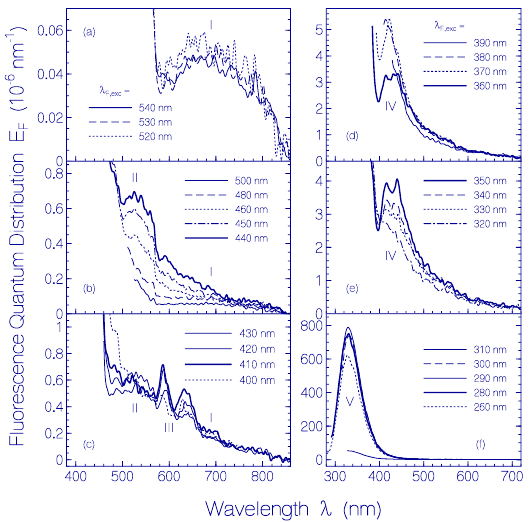
Figure 2. Fluorescence emission quantum distributions E F ( λ ) of fresh centrifuged CaRh in pH 7.3 HEPES/MOPS buffer for various fluorescence excitation wavelengths in the regions from ( a ) 540 to 520 nm; ( b ) 500 to 440 nm; ( c ) 430 to 400 nm; ( d ) 390 to 360 nm; ( e ) 350 to 320 nm, and ( f ) 310 to 260 nm. Numbers I–V indicate origins from different excitation